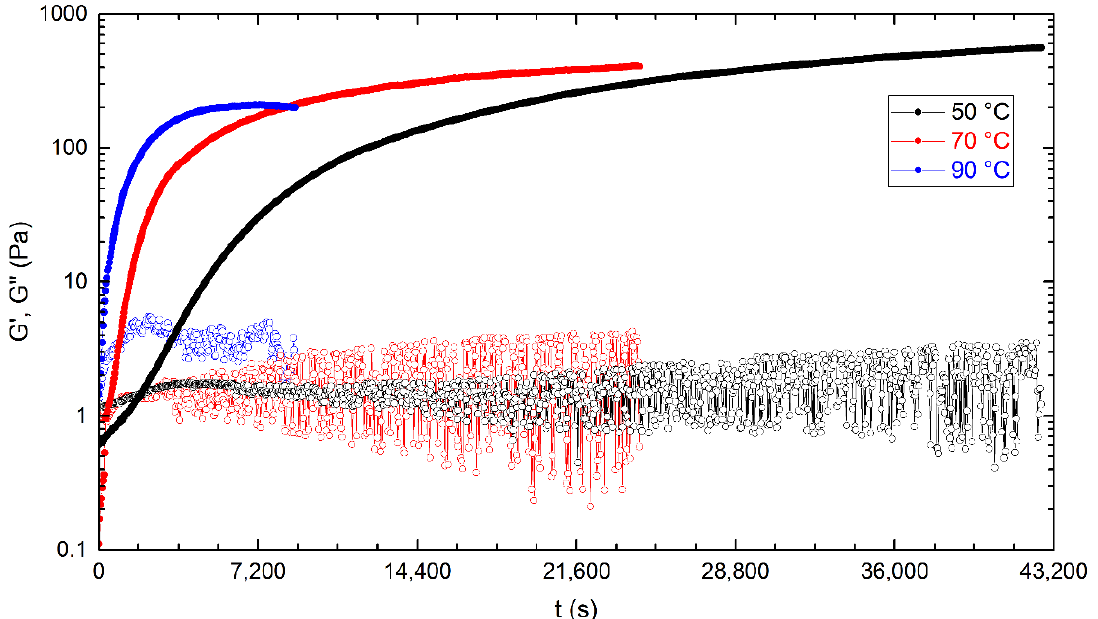
Figure 1. Evolution of storage modulus ( G ’), and loss modulus ( G ’’) with time for the system N- furfuryl-chitosan (21 % substitution degree) and PEG(mal) 2 -7500. Polymer concentration: 1 wt.%, and R = 0.25. G ’, closed symbols, and G ’’, open symbols. Only traces for ω = 1 rad·s −1 are shown.